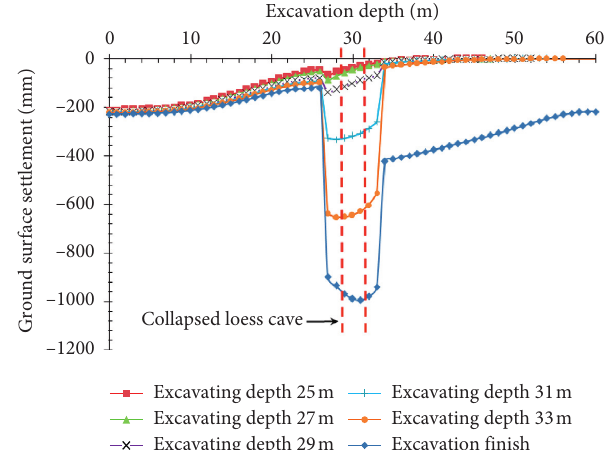
Figure 26: Ground settlement during passing through the collapsed loess